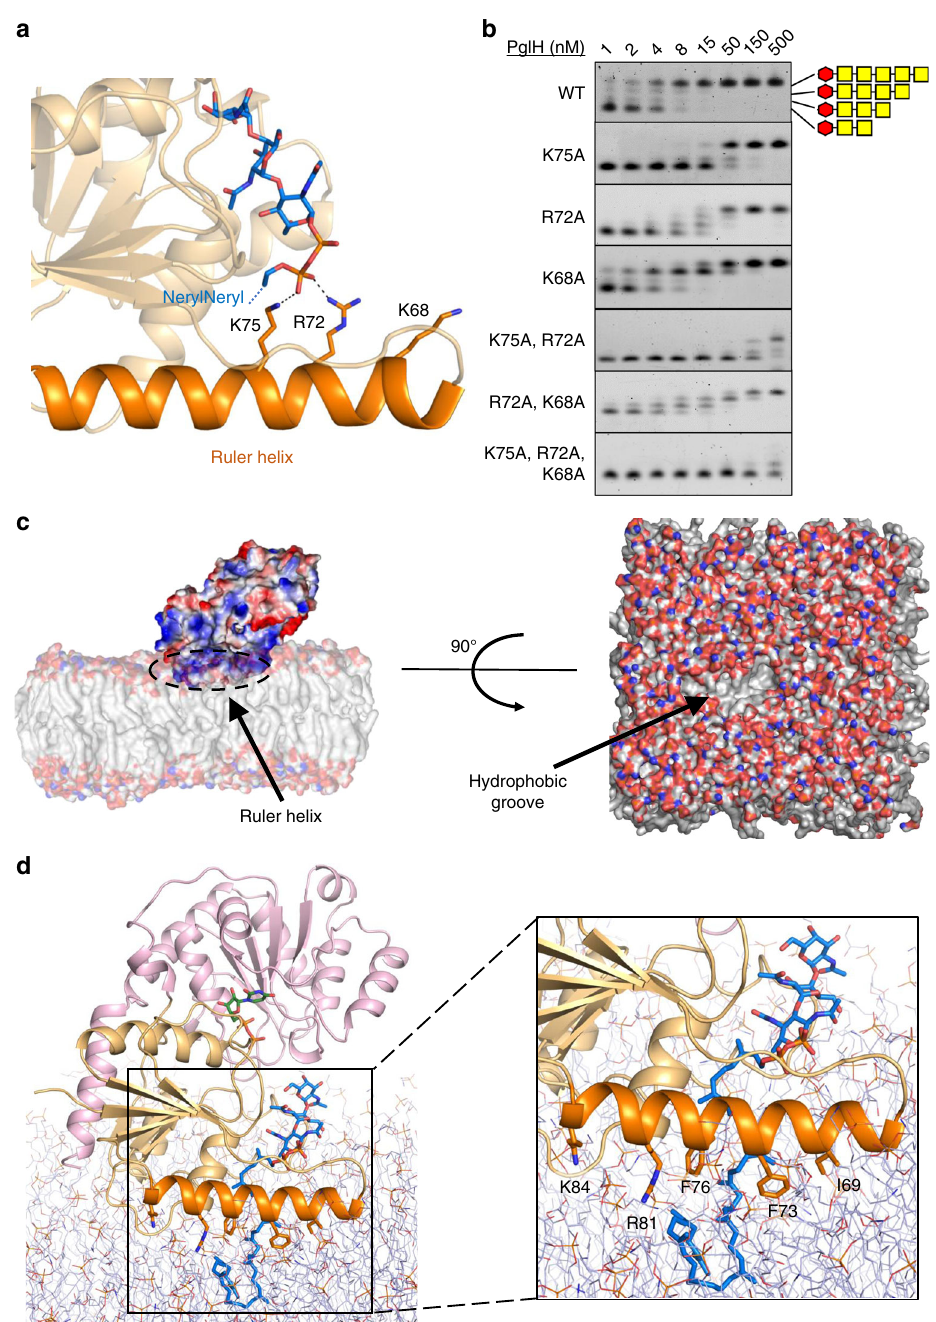
Fig. 4 Dual role of ruler helix α 2 in PglH. a Ribbon diagram of PglH bound to LLO analog as observed in the ternary complex PglH — UDP — LLO. The LLO analog and the three positively charged side chains of PglH interacting with the pyrophosphate group of the LLO are shown as sticks. Dashed lines depict salt bridge/hydrogen bond interactions. b Activity of wild type and mutant PglH. The reactions were performed for 10 min, after which the reactions stopped and the products were used as donor substrates for in vitro glycosylation of fl uorescently labeled peptide by PglB and analyzed by tricine SDS- PAGE. The amount of enzyme varied and is indicated on top of the lanes. c Left, interaction of PglH with the modeled lipid bilayer. The electrostatic surface of PglH is shown, and the position of the ruler helix is indicated by and arrow and labeled. Lipids are shown in surface representation. Right, the hydrophobic groove generated in the membrane upon displacement of lipid head groups by PglH is shown by an arrow and labeled. d Interaction of PglH with the membrane bilayer and with the native LLO substrate Und-PP-Bac-GalNAc 2 as determined by molecular dynamics simulations. PglH is shown as a ribbon, with bound UDP and LLO shown as sticks. Phospholipids are shown as thin lines. Coordinates of the glycan and pyrophosphate moieties of LLO were from the ternary complex structure, whereas the polyprenyl tail was modeled. The inset shows a close-up of the interaction between the ruler helix with the lipid bilayer and LLO. PglH residues contributing to the interactions with lipid head groups or tails are shown as sticks and